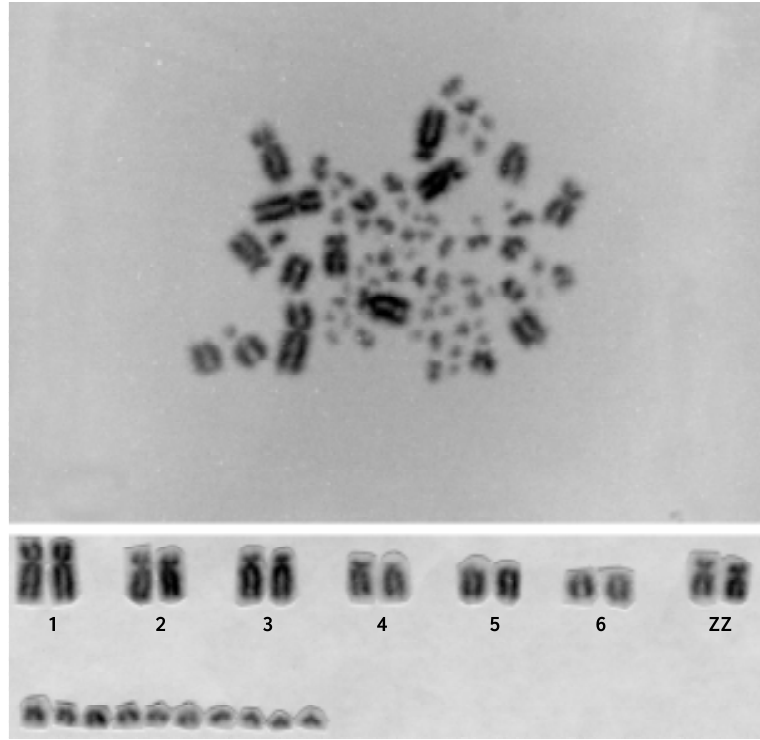
Figure 1 - Chromosomes of a male Oryzoborus maximiliani with a metaphase plate and partial karyogram.